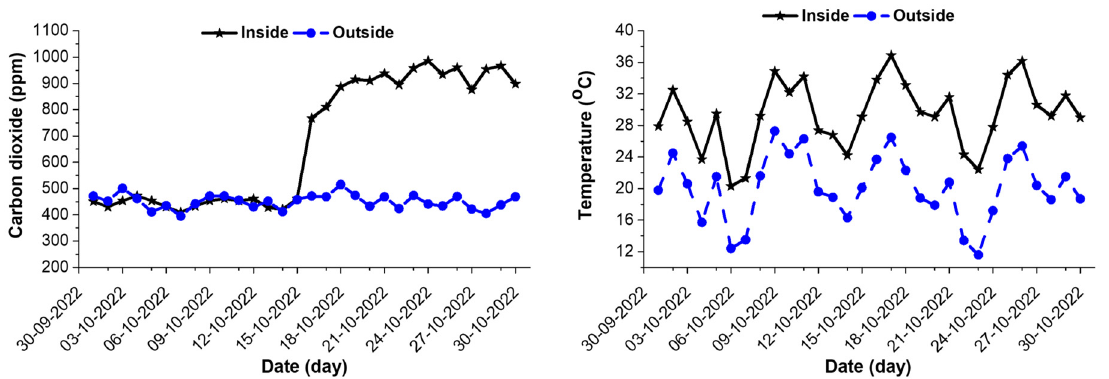
Figure 7. Changes in CO 2 concentration and temperature inside and outside the greenhouse environment during the experimental period in WCS (1 October to 15 October) and CS conditions 16 October to 30 October).